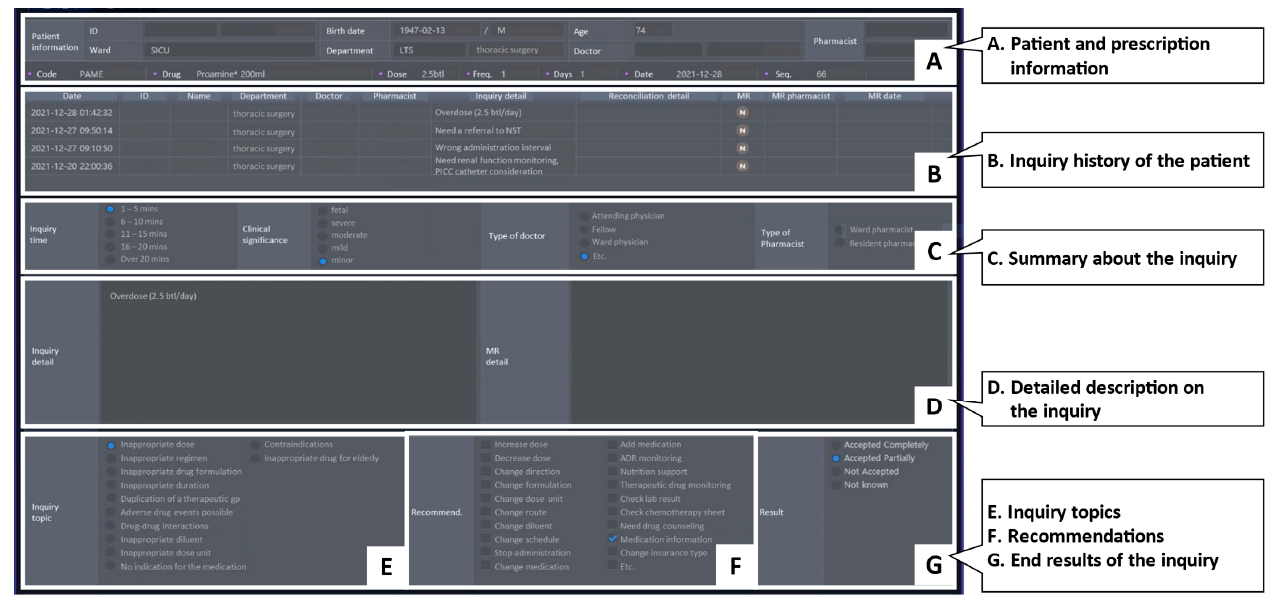
Figure 2. A captured screen of “pharmacy inquiry” in the homegrown health information system, BESTCare ® , was displayed and all contents in the screen have been translated into English for publication. The screen enables the pharmacists to document detailed inquiries, such as patient and prescription information, inquiry history of the patient, summary of the inquiry including time, type of clinician, detailed description on the inquiry, inquiry topics, recommendations, and end results of the inquiry. The pharmacy inquiry is stored in the electronic database and is shared by all pharmacists for further patient-centered care.